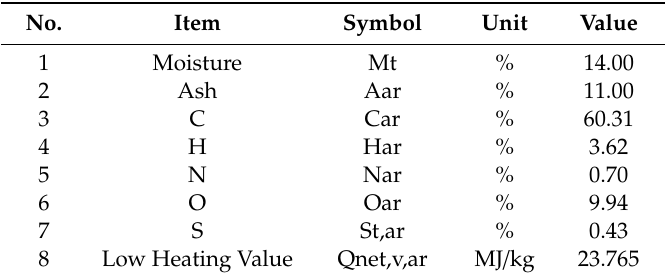
Table 1. Fuel characteristics of the N600-24.2 / 566 / 566 unit.